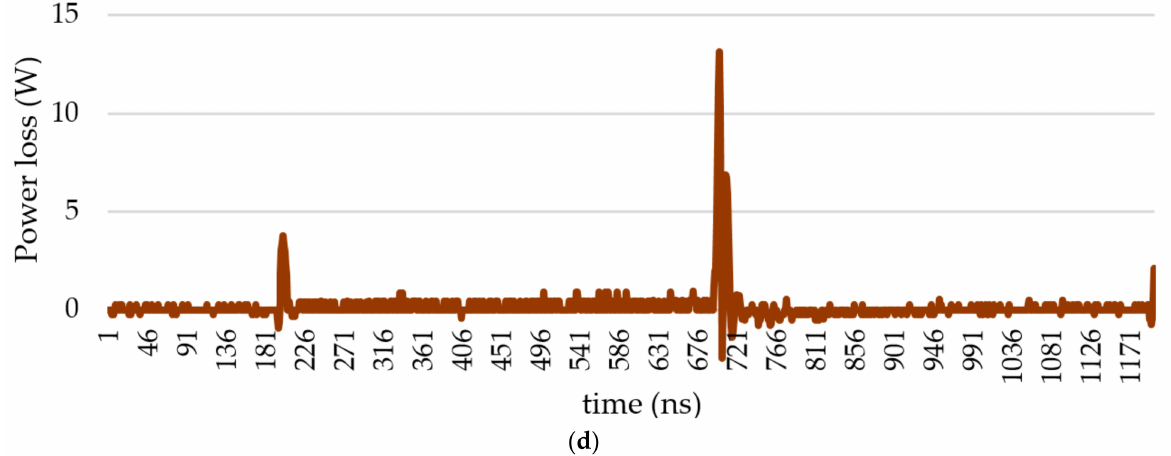
Figure 16. The experimental result for 12 V to 6.5 V step down at a switching frequency of 500 kHz and δ = 50%: ( a ) oscilloscope photo; ( b ) v sd of PMOS and v sd of the GaN HEMT data plot; ( c ) current i o and i d plot; and ( d ) the instantaneous power loss (( b – d ): 2 ns per tick). Table 3. The input parasitic capacitance Ciss at a switching frequency of 1 MHz.